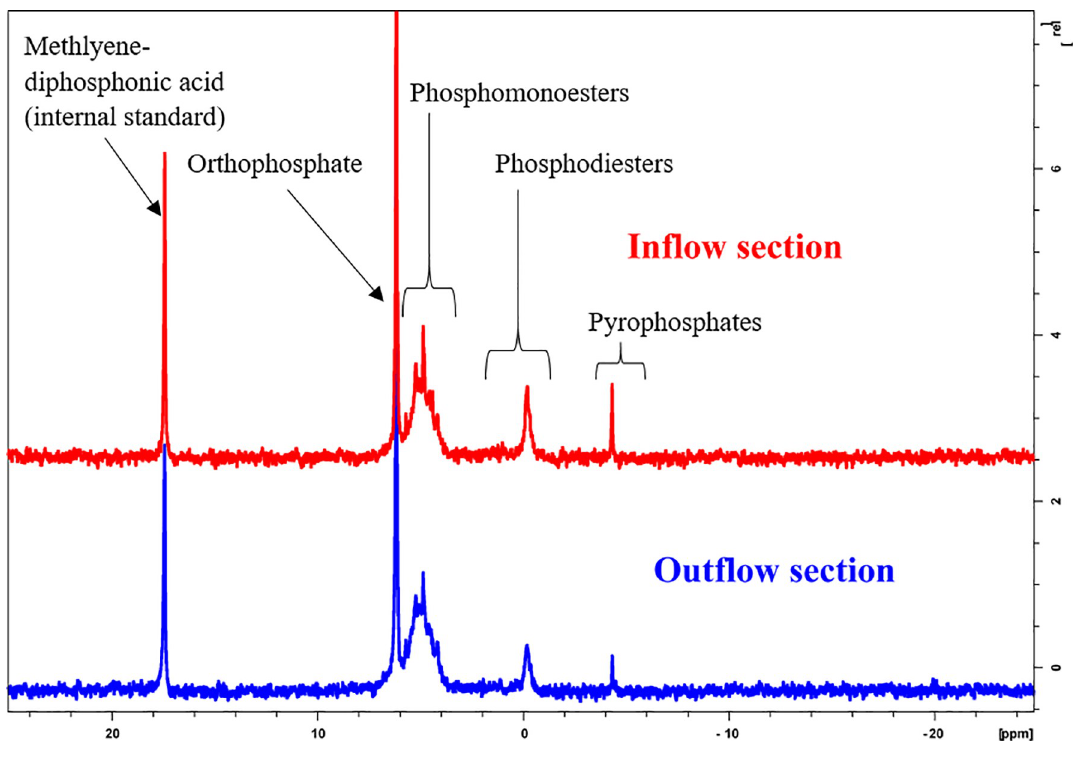
Fig 7. P-31NMR spectra of inflow and outflow sediments of treatment ditch